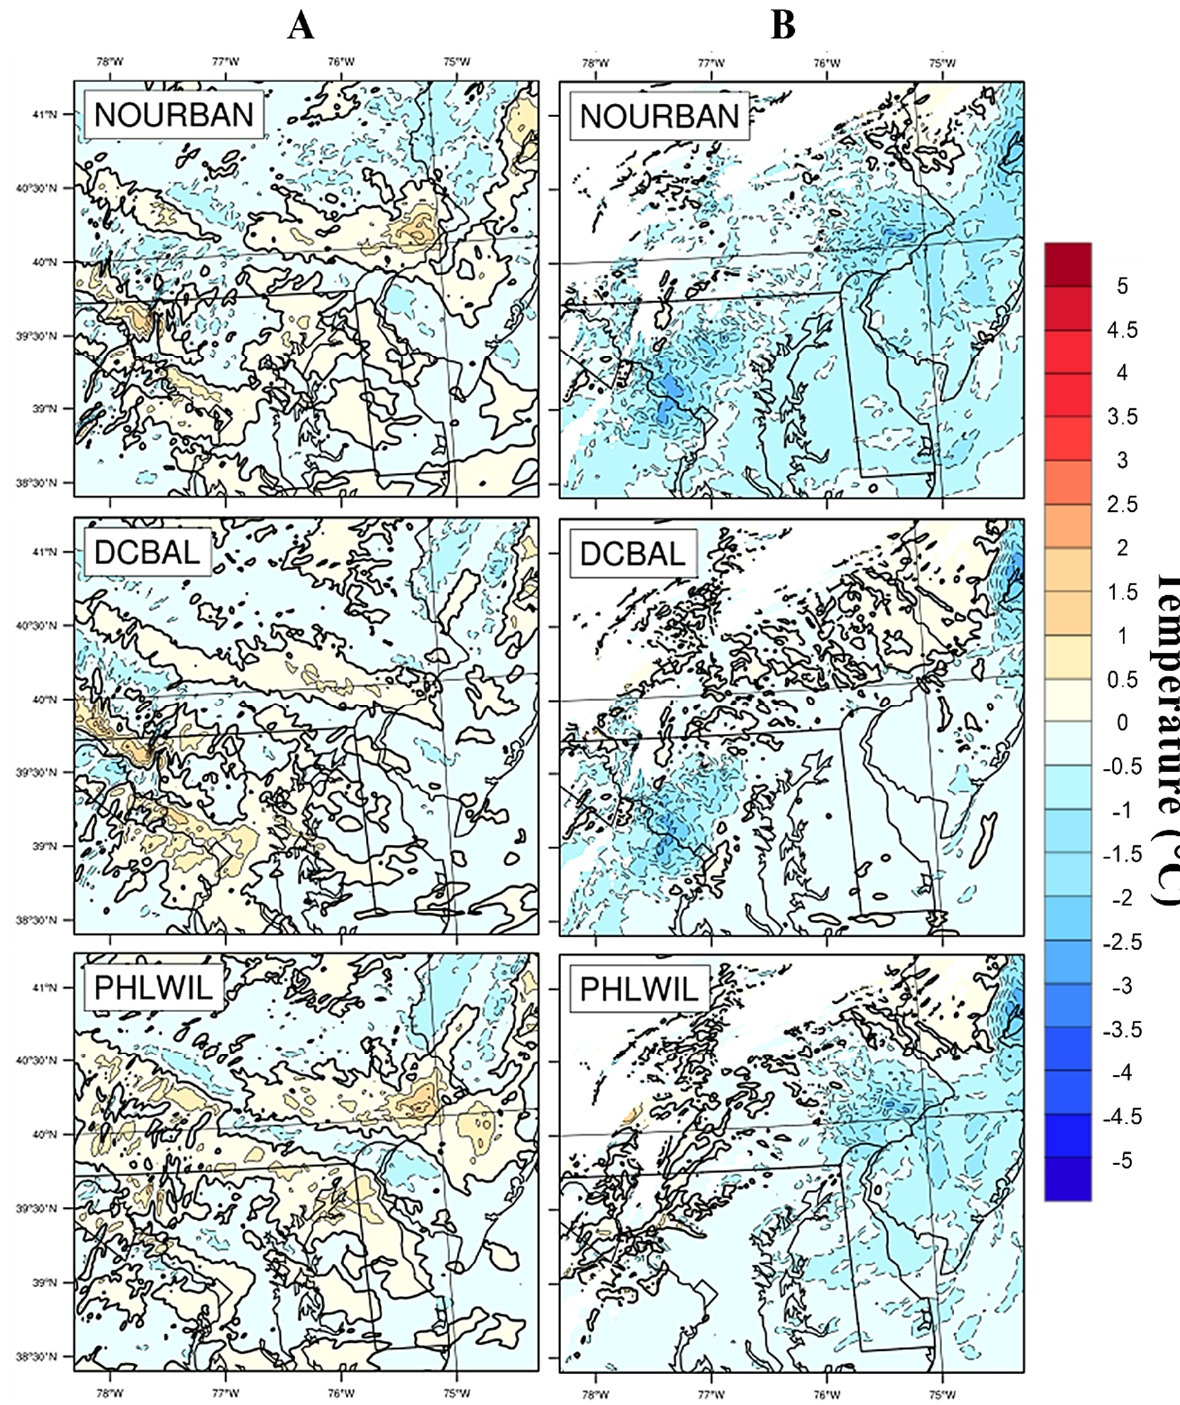
Figure 9. WRF-simulated 925 mb ( left, Column A ) and 1000 mb ( right, Column B ) temperature difference (°C) from the control ( T modified − T control ). Valid at 0000 UTC on 6 February